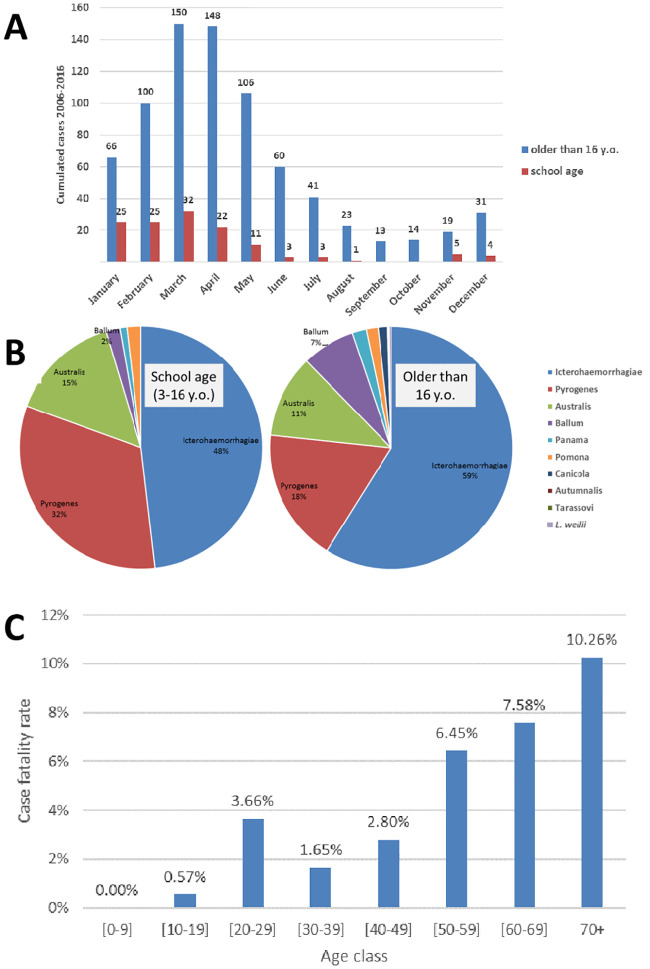
Age-specific epidemiological patterns of laboratory-diagnosed human leptospirosis in New Caledonia from 2006 to 2016.Panel A shows difference in seasonality between school age (3–16 y.o.) and older patients. Panel B shows the relative contribution of the different serogroups in documented infections (n = 743) (One Leptospira weilii infection was acquired overseas). Panel C shows the case fatality rate in the different age classes.